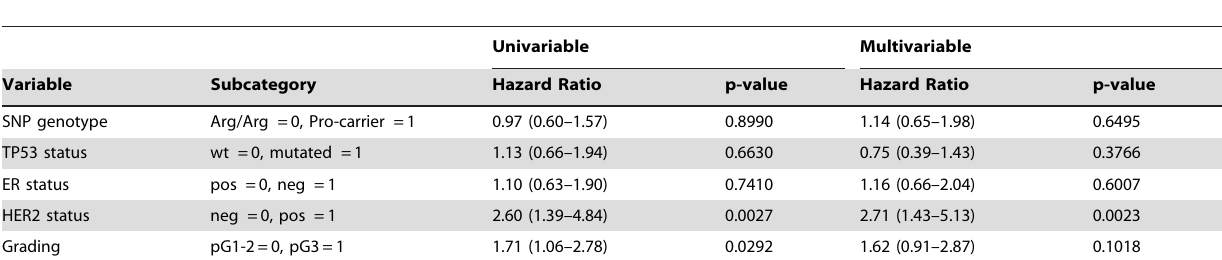
Table 4. Univariable and multivariable analyses of the overall survival using a Cox proportional hazards model.